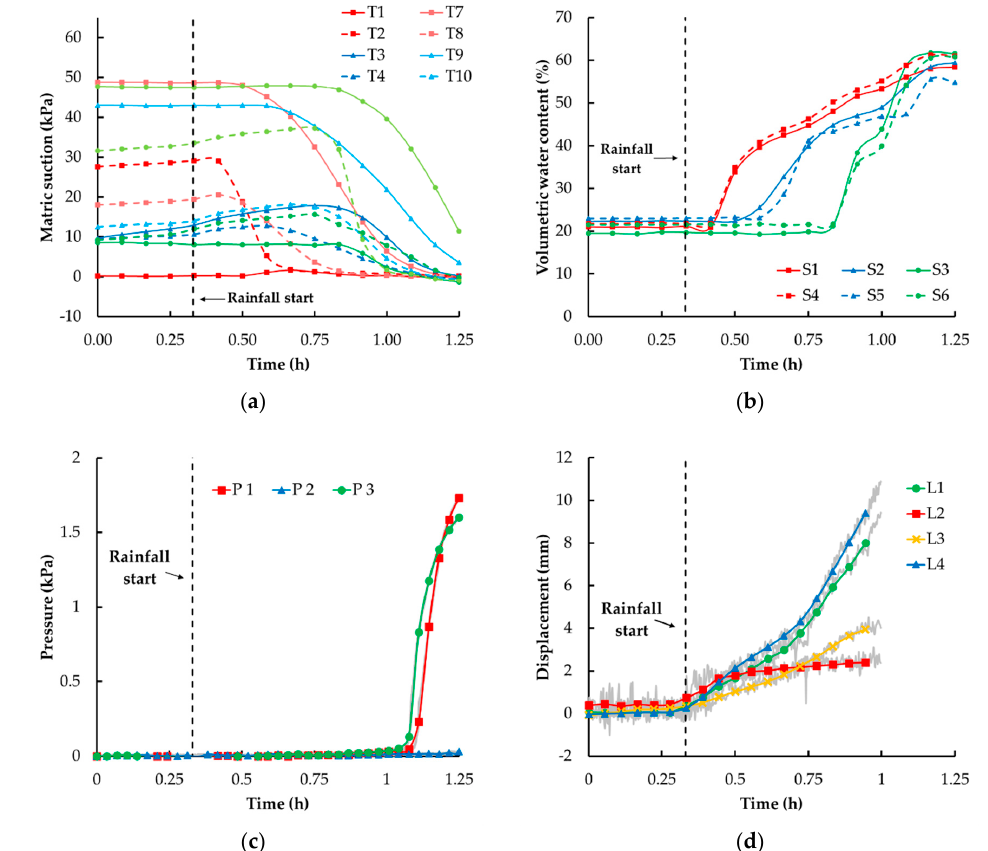
Figure 11. Parameters graphs monitored during the infiltration phase in the horizontal deposit: ( a ) suction; ( b ) volumetric water content; ( c ) pore water pressure at the bottom of flume; and ( d ) orthogonal displacements by the soil surface.